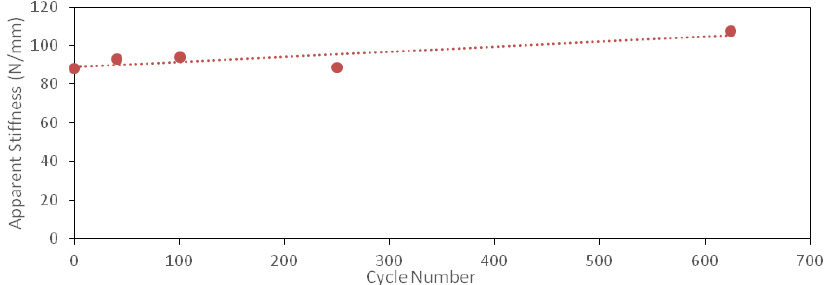
Figure 15. Apparent stiffness vs. number of cycles for the control specimens. Each cycle is equivalent to 2 h. to 2